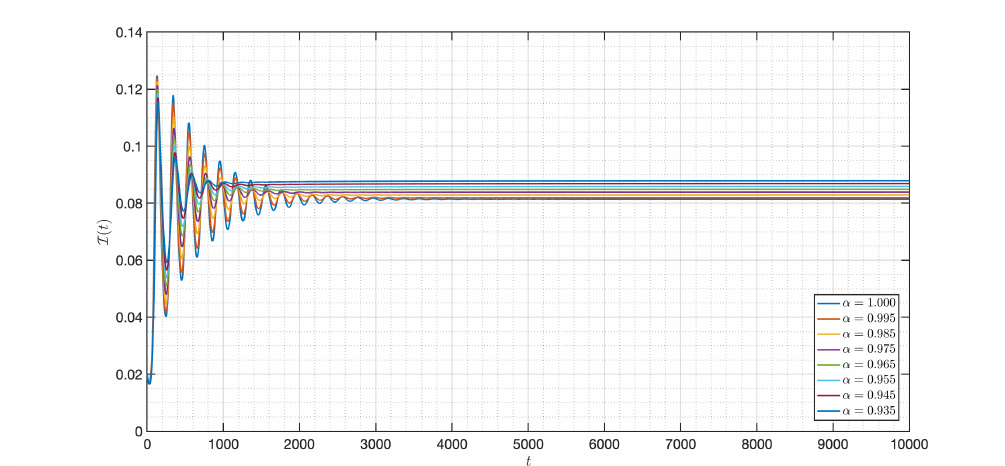
Figure 26. Dynamic of I ( t ) the model (3) for different parameters in Case III .